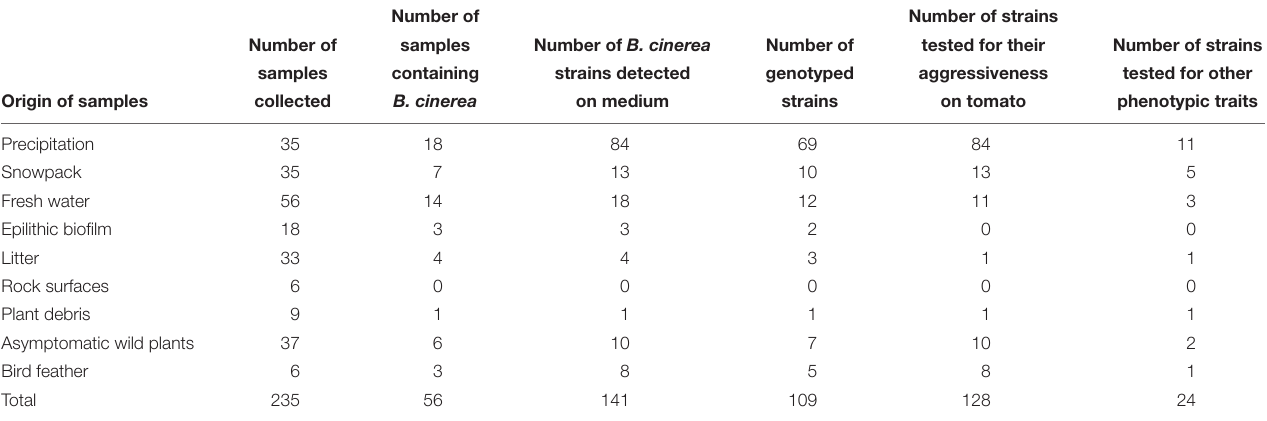
TABLE 1 | Quantification of the number of Botrytis cinerea strains collected in non-agricultural habitats (environmental strains) and number of strains tested for different traits. Number